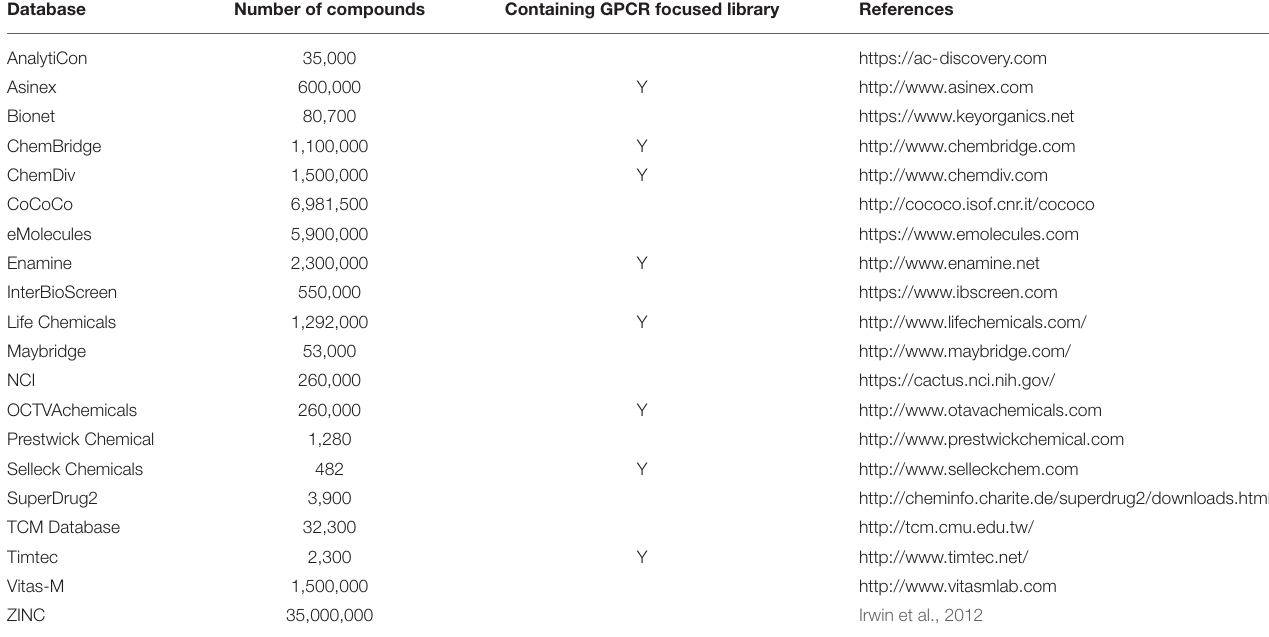
TABLE 5 | Available chemical database for high-throughput virtual